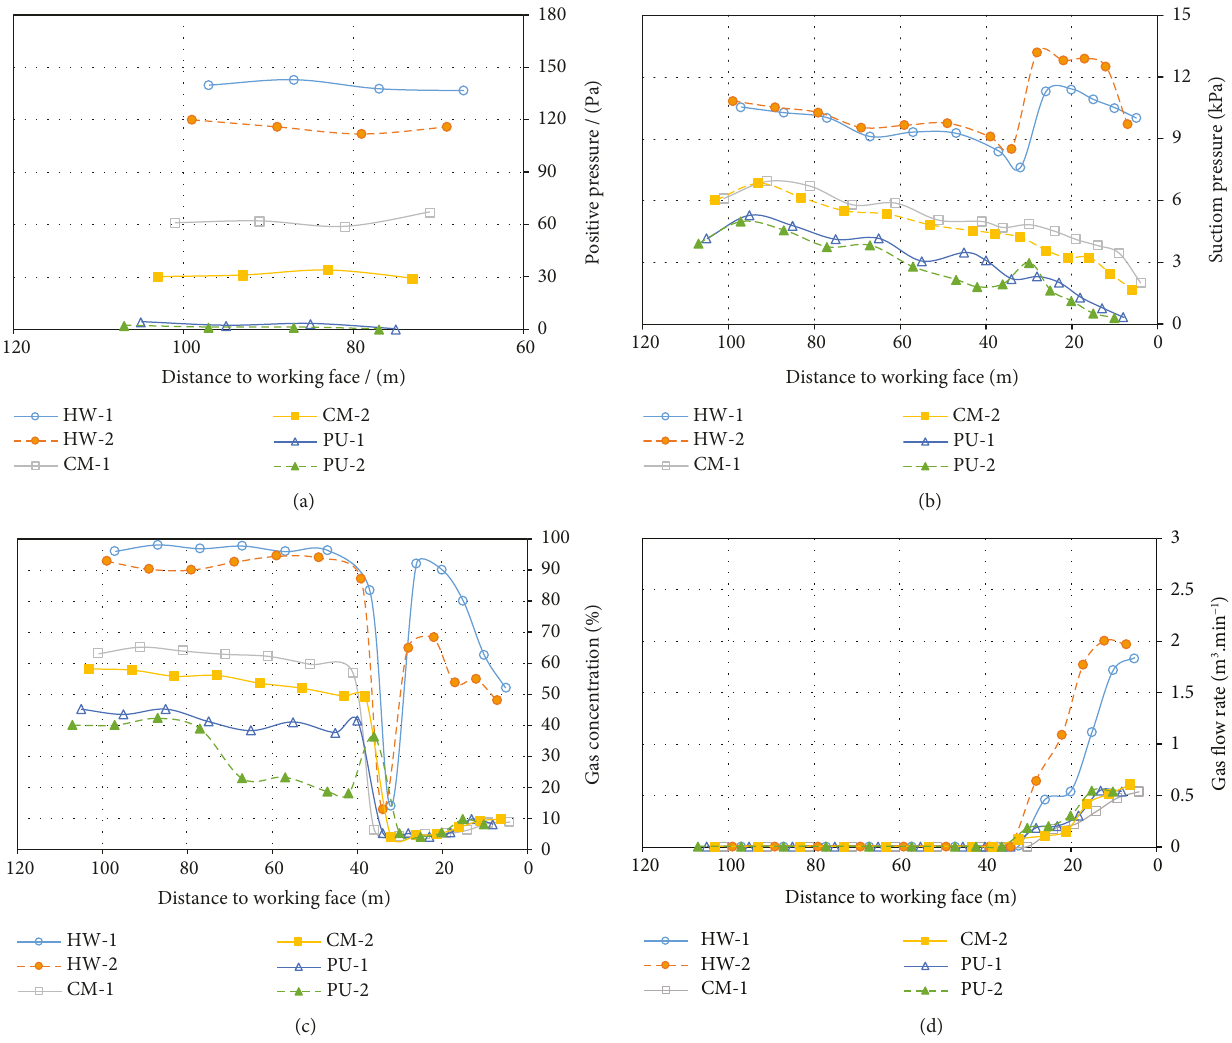
Figure 11: Tightness and gas drainage e ff ect for boreholes under di ff erent borehole-sealing materials and borehole-sealing techniques. (a) Positive pressure. (b) Suction pressure. (c) Gas concentration. (d) Gas fl ow